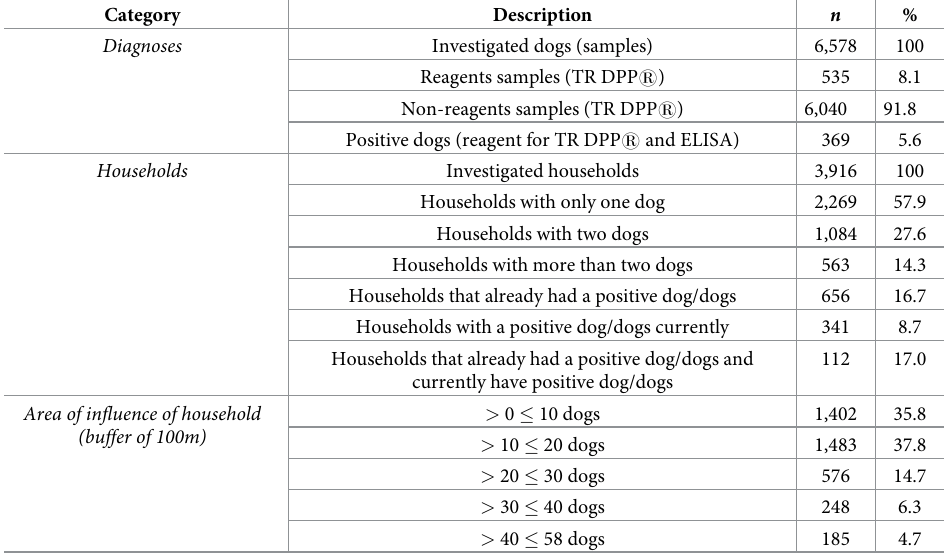
Table 1. CVL diagnostic, dog count in the households, and buffer zone extraction versus the number of sampled dogs in Bauru.